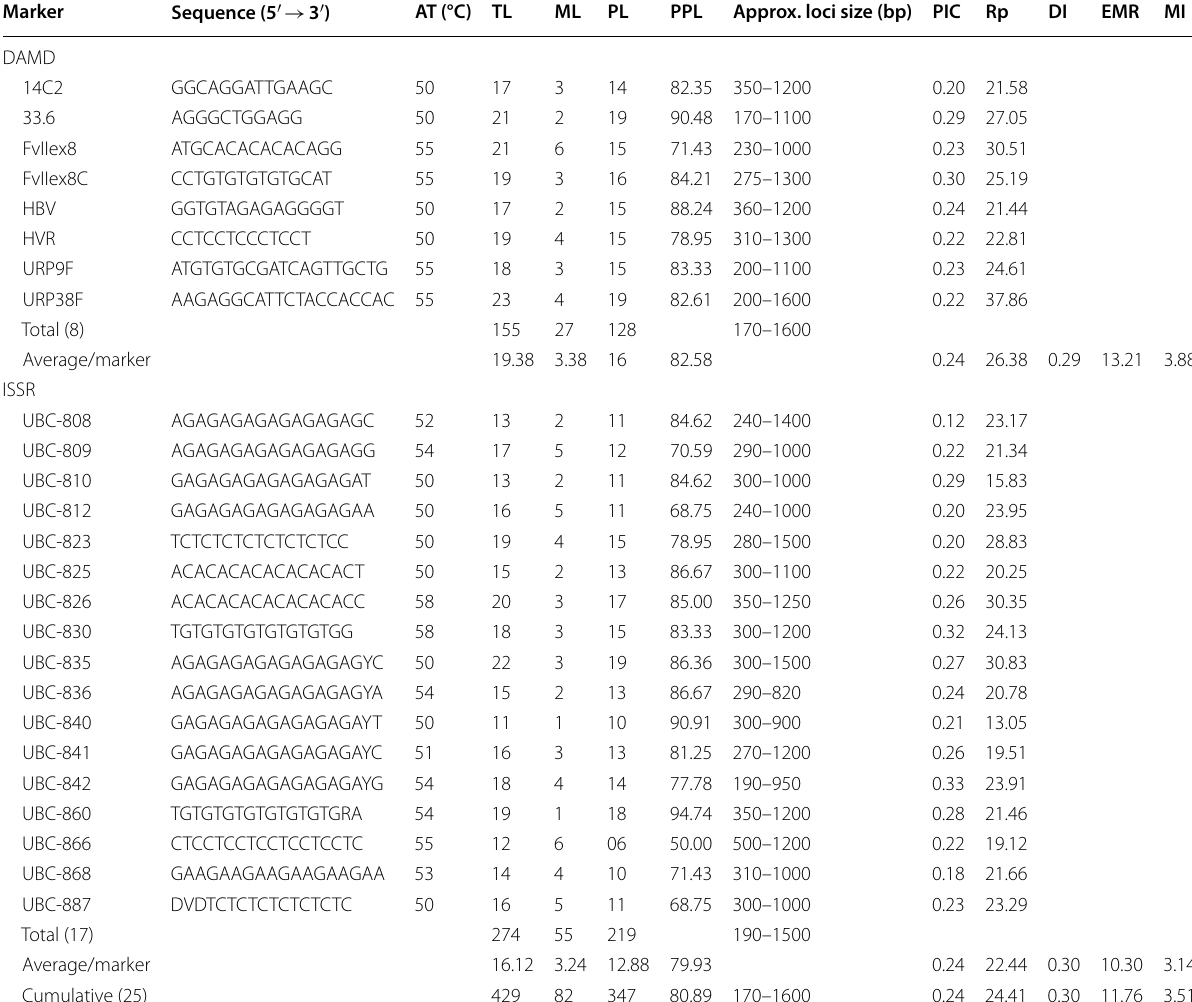
Table 2 Details of DAMD and ISSR markers and the polymorphism obtained with these markers